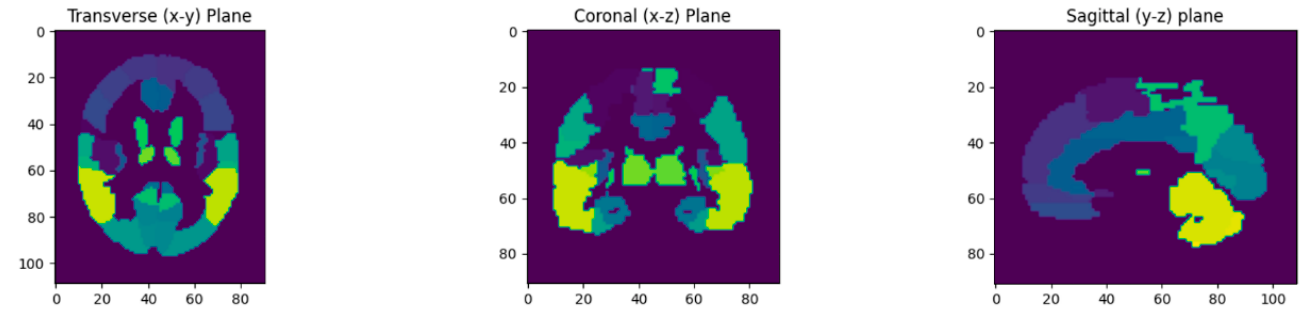
Figure 3. The volumes of interest (VOIs) used for the image quality analysis, as defined in the AAL Merged Atlas in PMOD. Colors indicate discrete VOI numbering from 1 to 71 (with four indices not present).